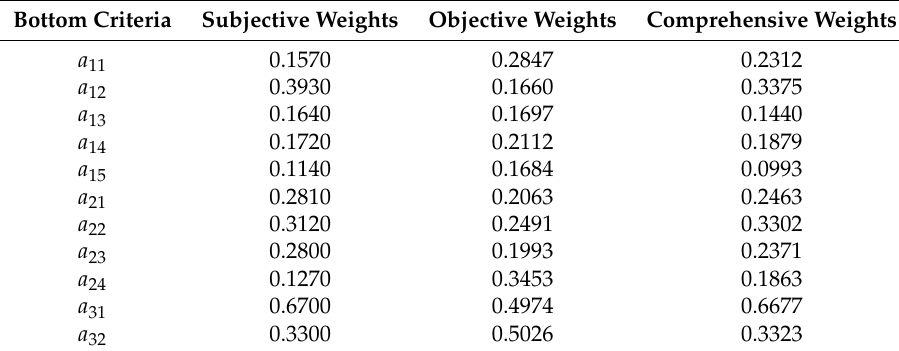
Table 5. Comprehensive weights of bottom